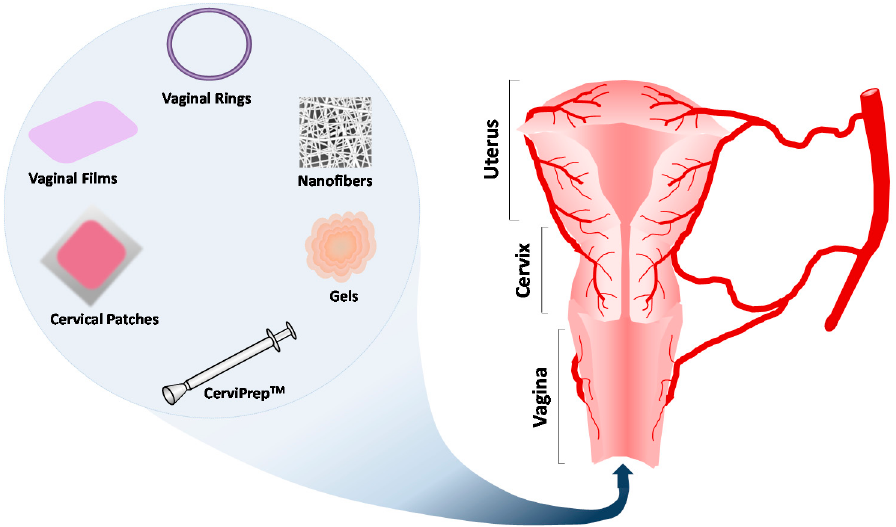
Figure 3. Drug Localized Drug Delivery systems used in cervical cancer, including vaginal rings, vaginal films, cervical patches, nanofibers, gels and CerviPrep™.